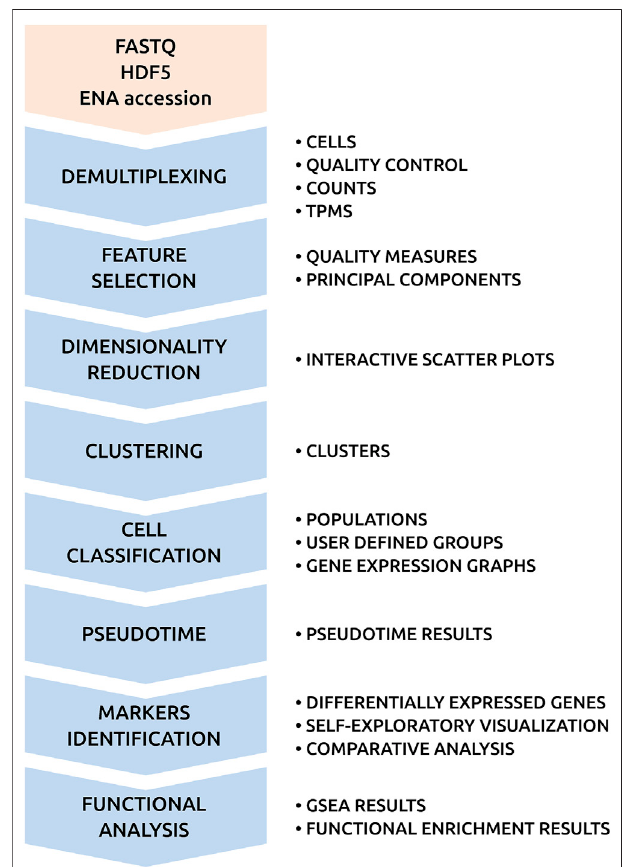
FIGURE 2 | SingleCAnalyzer Pipeline. Chart of SingleCAnalyzer pipeline with computational processes and output